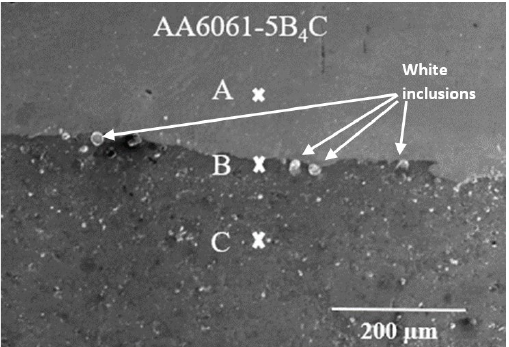
Figure 10. Three-point EDX study of AA6061-5%B 4 C joint sample friction stud welded under normal conditions.